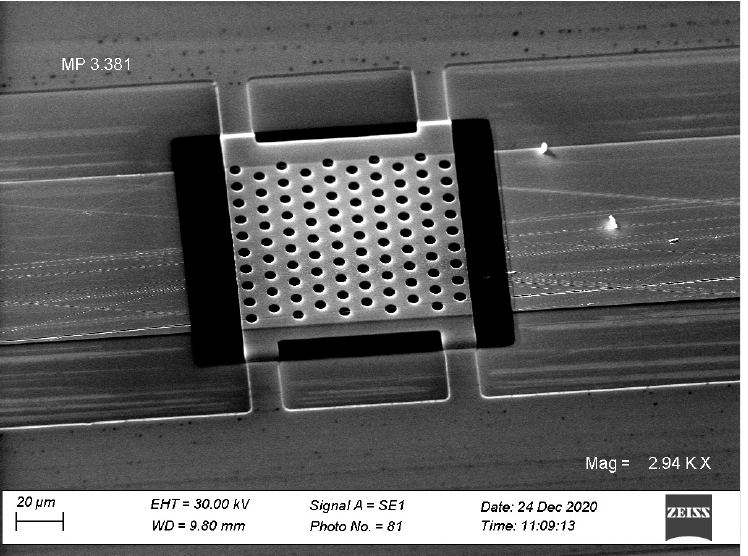
Figure 2. Electronic photograph of the